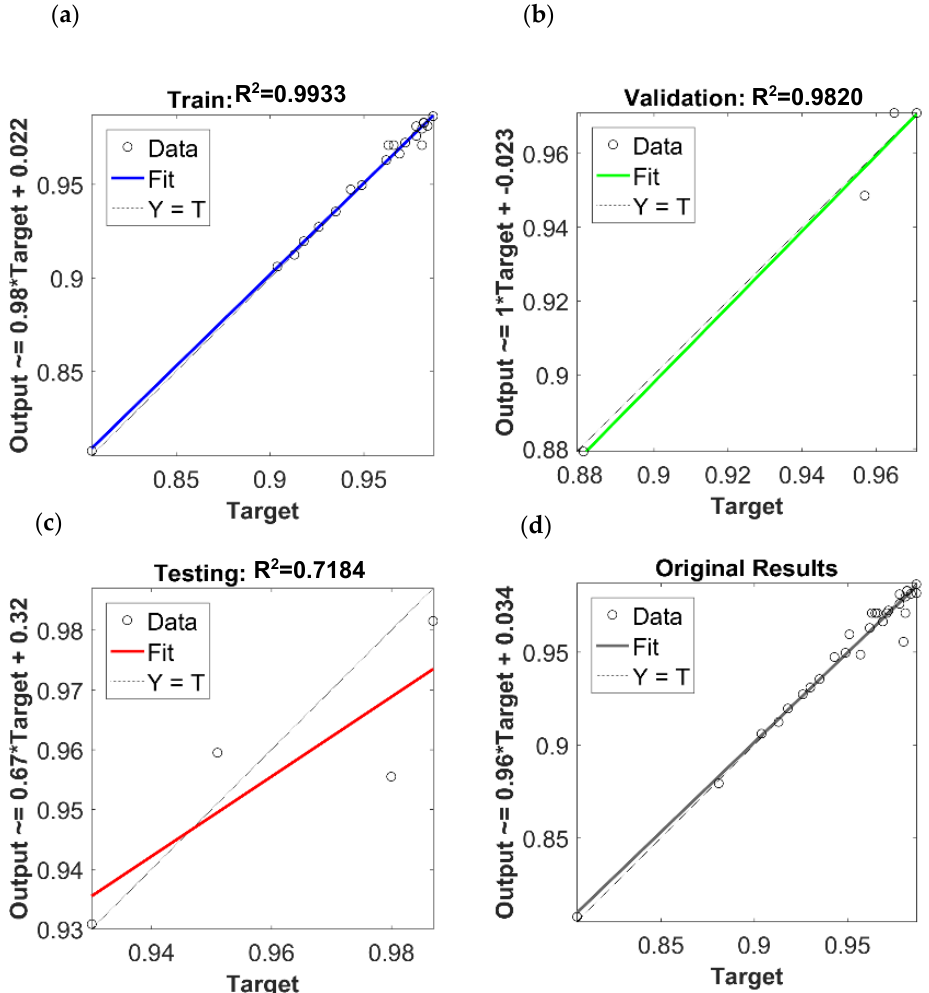
Figure 5. The scatter plots of ANN model predicted values (rejection rate of nickel ions) versus experimental values for ( a ) training, ( b ) validation, ( c ) testing, and ( d ) all data sets.